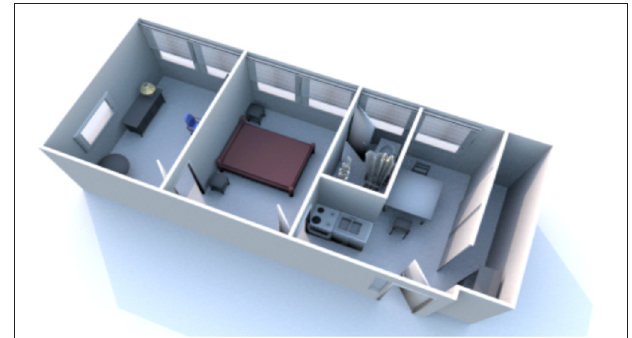
FIGURE 1 | The “Domus” Smart